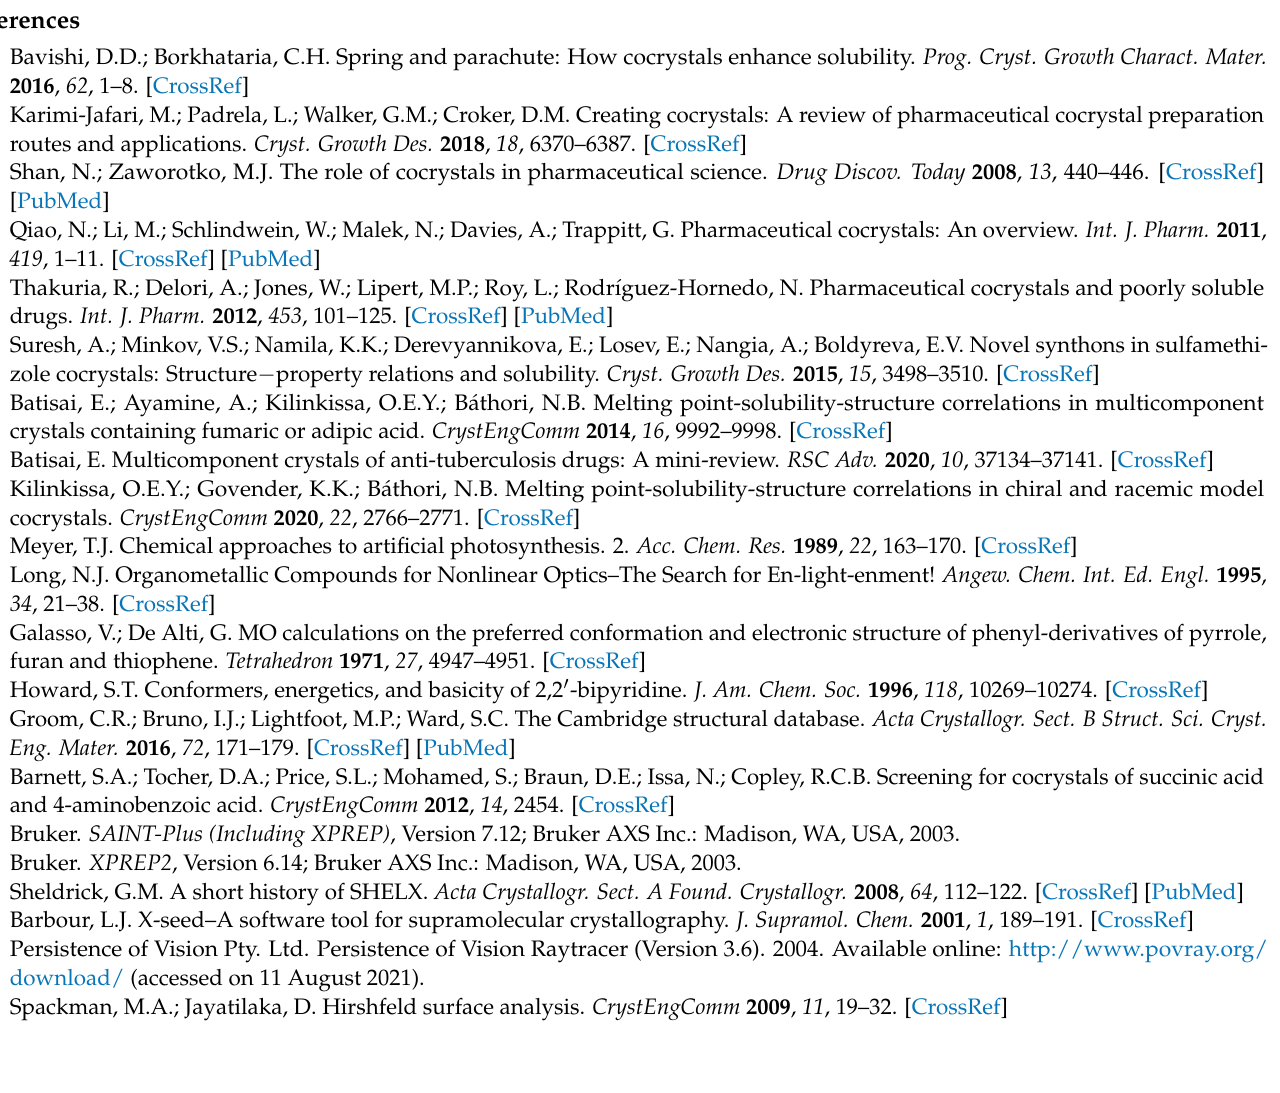
Figure S7. 2D fingerprint plots of BPY · SUC, BPY 2H + · 2MAL and BPY H + · OXA − showing the C ··· C, C ··· N and C ··· O interactions; Figure S8. Results of CSD search on the BPY molecule; Figure S9. Results of CSD search on monoprotonated BPY; Figure S10. Results of CSD analysis on diprotonated